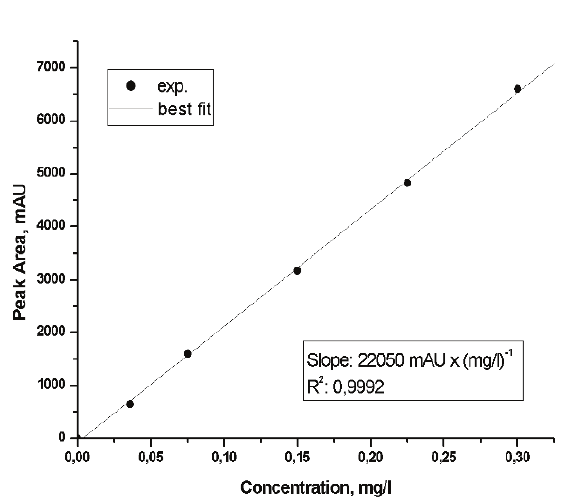
Figure 4. Calibration curve for HPLC determination of model pollutant EE2.